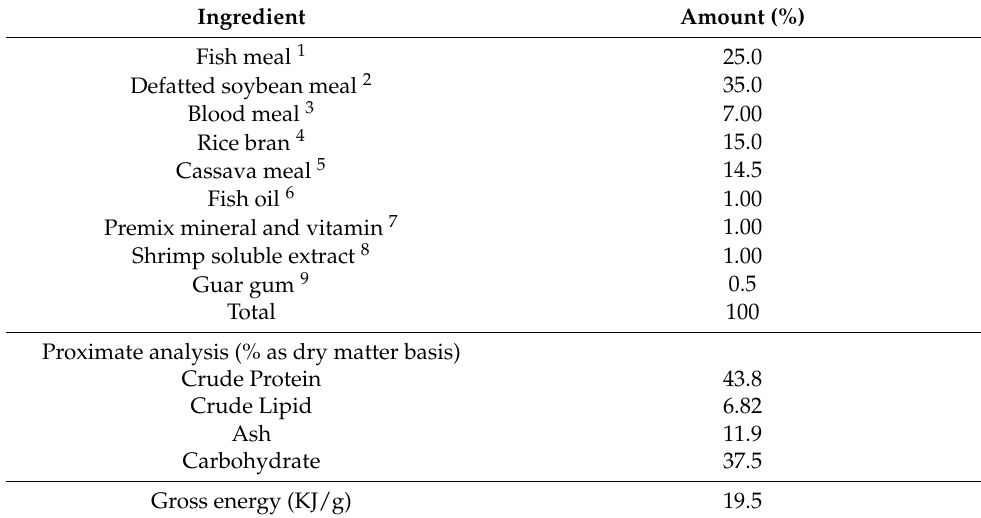
Table 1. Chemical composition of basal diet (dry matter basis).